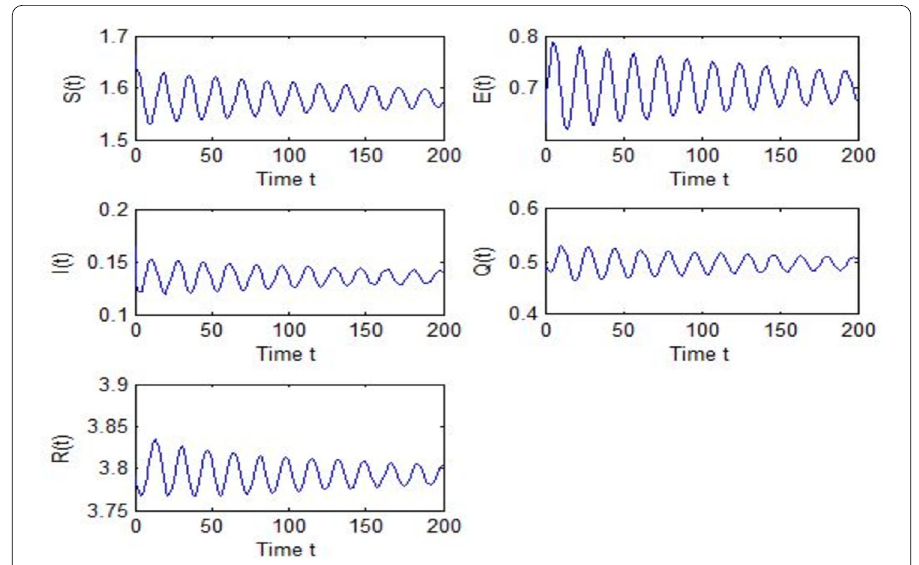
Figure 8 Evolutions of S , E , I , Q , R for τ 1 = 4.6292 > τ 10 , τ 2 = 2.299 along with time